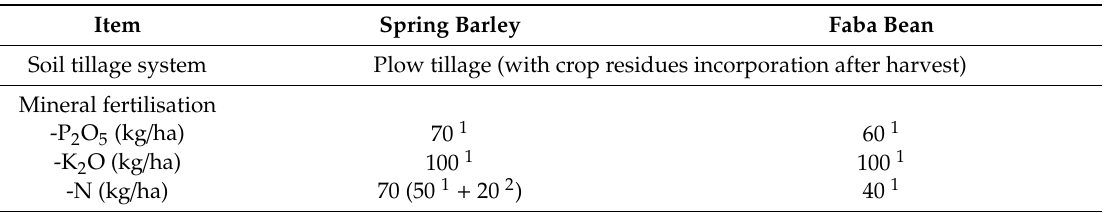
Table 1. Basic agricultural data for spring barley and faba bean in